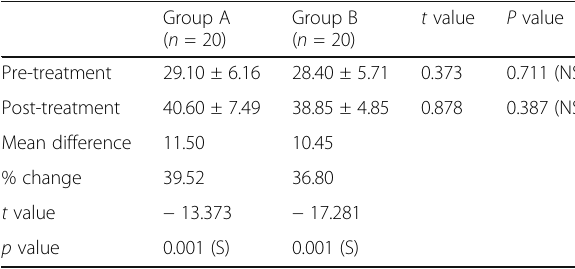
Table 6 Comparison of mean values of right side bending within and between both groups